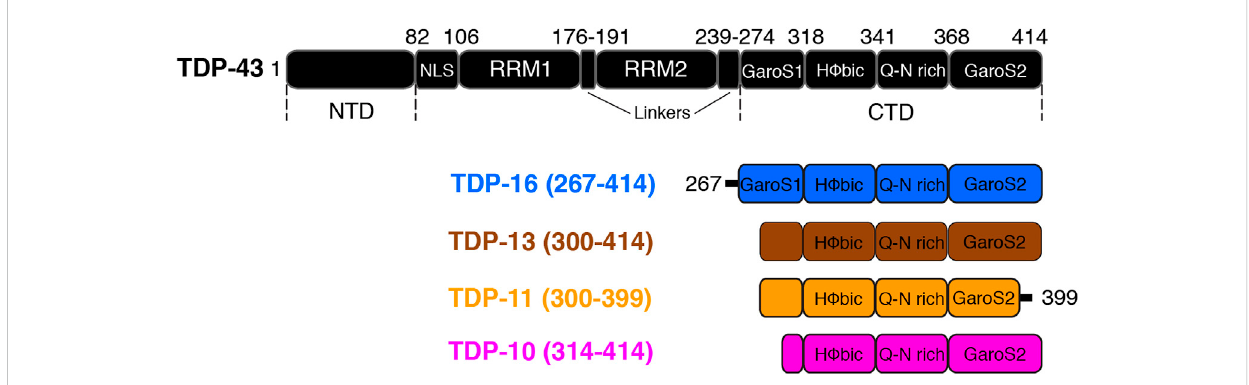
Sequences of TDP-43 and various low-complexity C-terminal domain fragments used in this study. Boxes are used to denote different functional/ structural domains. The nomenclature of the different CTD fragments is chosen to be consistent with (Mompean et al., 2016b; Shenoy et al.,